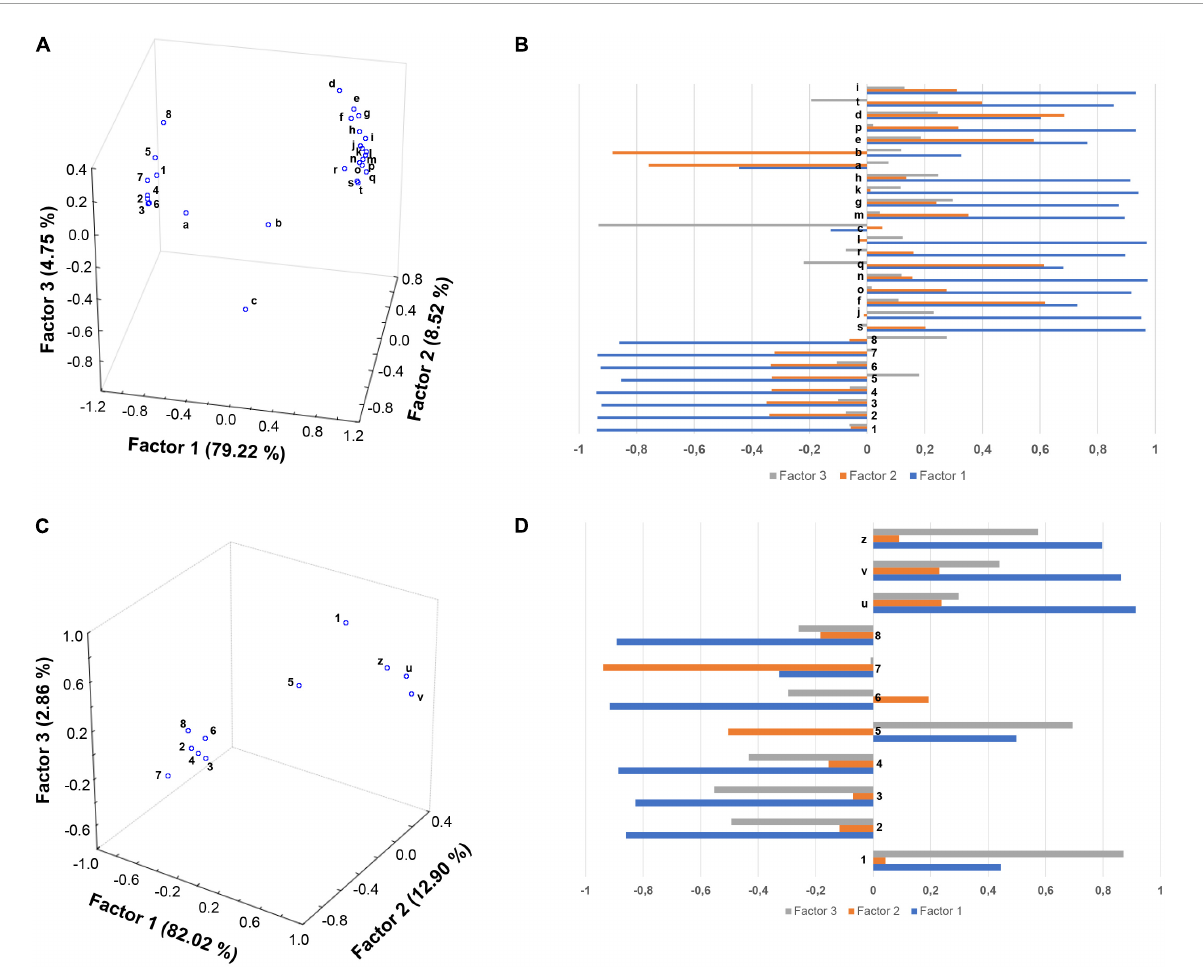
FIGURE5 Factor analysis indicates a good correlation between the EVOO chemical profile and the biological modulations. Score plots (A,C) and factor loadings (B,D) relative to oil polyphenols and gene expression data at 6 h (A,B) , and protein data at 6 and 24 h (C,D) were reported. Olive oil polyphenols: (1) 3-hydroxytyrosol; (2) oleuropein isomers; (3) oleuropein aglycone forms; (4) oleochantalic acid; (5) luteolin; (6) ligstroside aglycone forms; (7) apigenin; (8) methoxyluteolin. mRNAs: (a) NQO1 ; (b) NR4A2 ; (c) INF γ ; (d) SSP1 ; (e) PPAR γ ; (f) CCL2 ; (g) MMP14 ; (h) MS4A4A